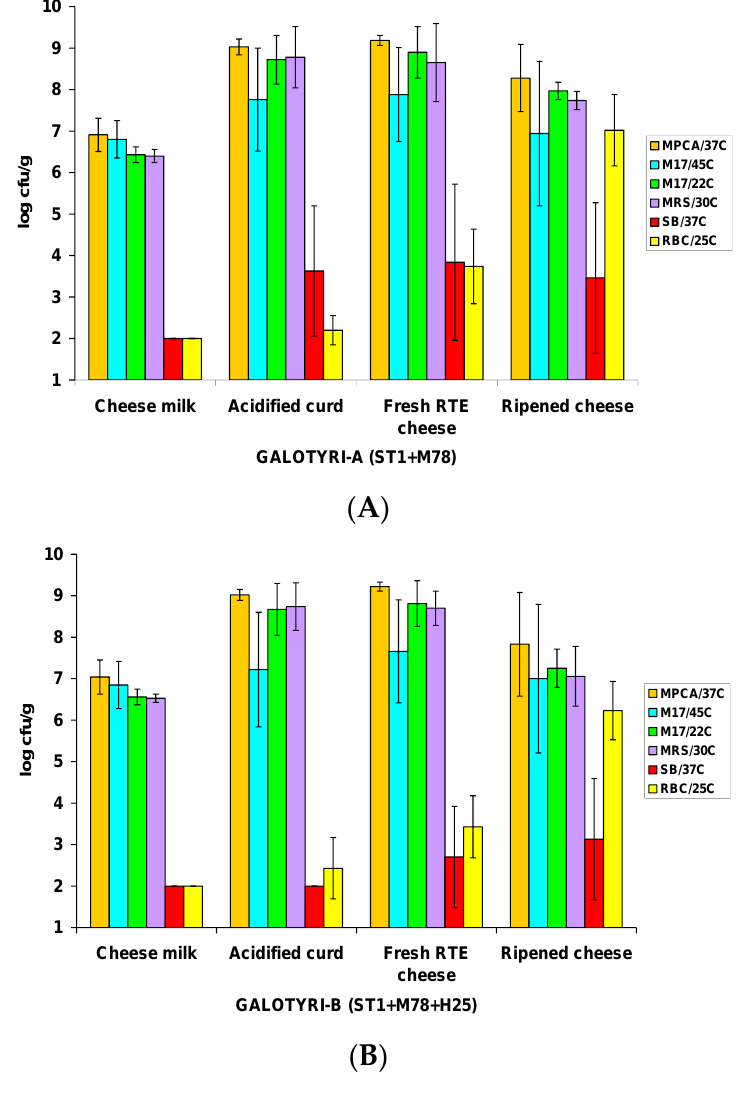
Figure 2. Microbial evolution in artisanalGalotyri cheeses manufactured without ( A ) or with ( B ) sup- plementation of the basic starter culture (ST1+M78) with the adjunct strain L. plantarum H25. The mean total viable counts (TVCs), mainly reflecting the total dominant starter/adjunct LAB populations in boiled (85 ◦ C) milk after inoculation with the ST1, M78, and H25 strains (step 1; Figure 1), were 6.91 ± 0.40 log CFU/g and 7.04 ± 0.41 log CFU/g in the Galotyri A and Galotyri B cheese milk samples, respectively. The TVCs increased by ca.